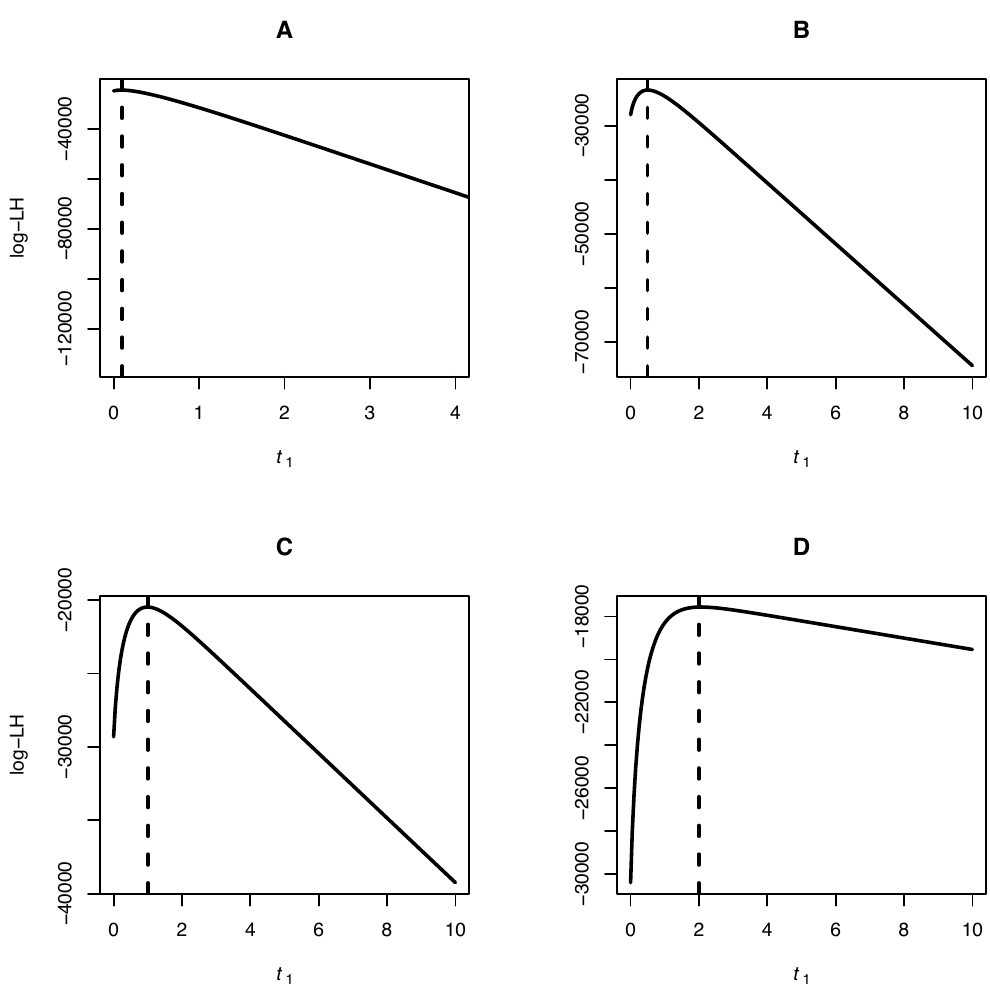
Figure 2. Pure drift model. Likelihood curves of the parameter t 1 given a sample of L = 10,000, M 0 = M 1 = 3 and true t 1 (dashed vertical lines) equal to 0.1 ( A ), 0.5 ( B ), 1 ( C ) and 2 ( D